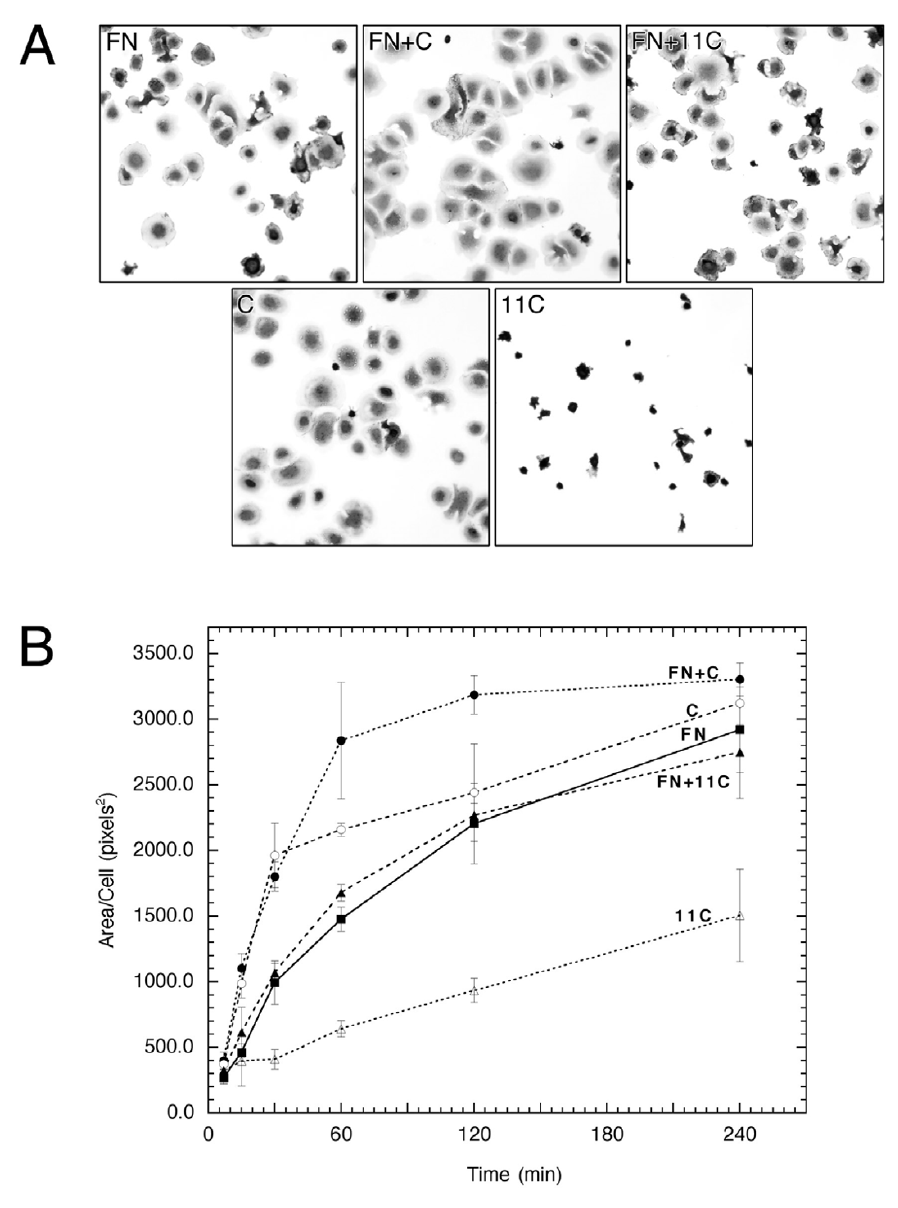
Figure 1 Effect of III1-C on cell spreading. Panel A. RASMCs were plated onto either uncoated dishes (C and 11C panels) or dishes coated with 20 µ g/ml fibronectin (FN, FN+C and FN+11C panels) in the presence of either no recombinant protein in the media (FN panel), or 25 µ M III1-C (FN+C and C panels), or 25 µ M III 11-C in the media (FN+11C and 11C panels). After 30 min at 37 ° C the cells were fixed, stained with coomassie blue and photographed under a light microscope. Bar equals 100 µ m. Panel B. Quantitation of cell spreading over time in the culture conditions described for Panel A. Each data point is the average of four samples; similar results were obtained from four independent